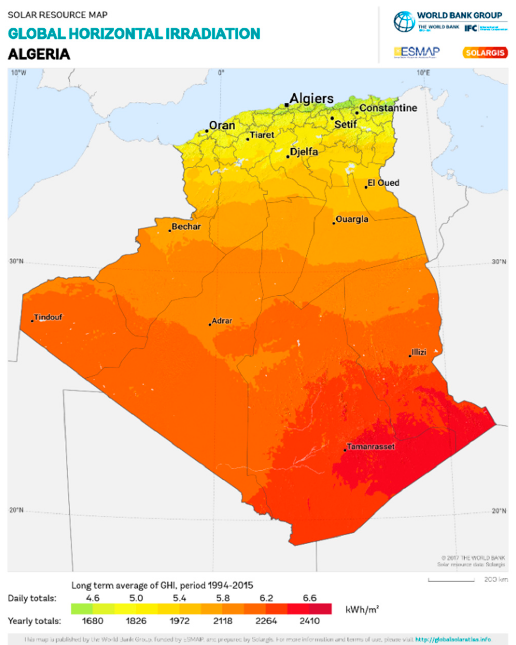
Table 1. radiation in Algeria [49].